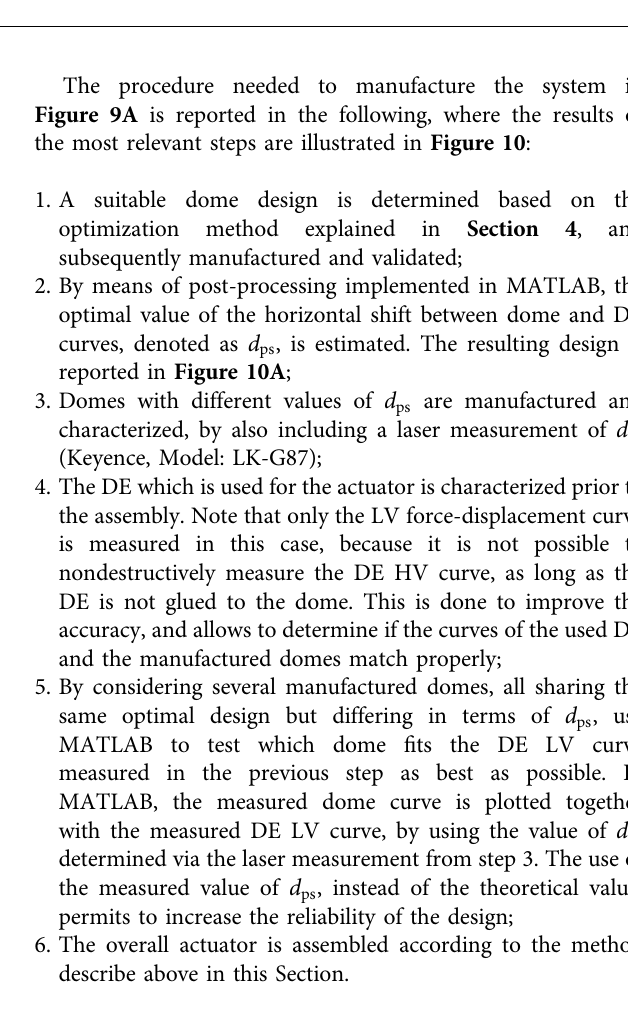
FIGURE 9 | (A) Rendered explosion view of the fl exible DEA. Sketch of the assembled actuator together with the system force-displacement curves, (B) without voltage and (C) with high voltage applied to the